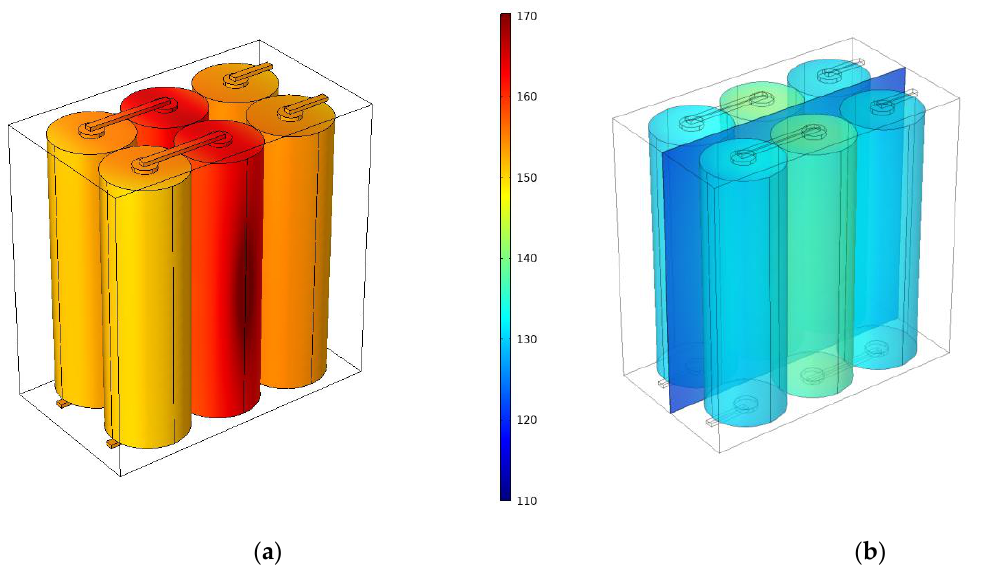
Figure 16. ( a ) Temperature distribution inside the battery pack without the heat spreader; ( b ) tem-